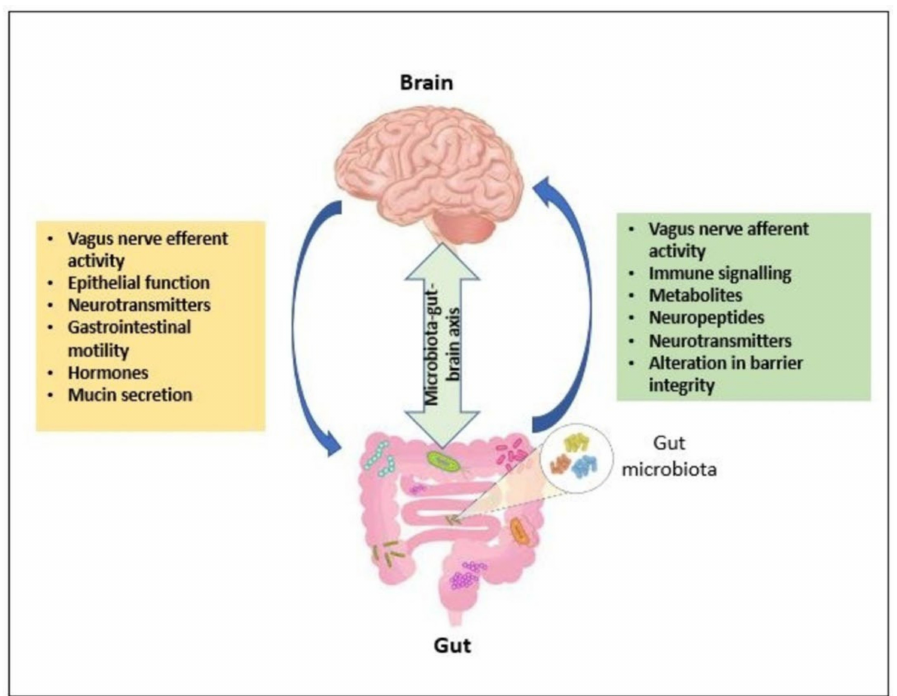
Figure 3. The microbiota–gut–brain axis. The bi-directional channel of communication between the brain, gut, and microbiota occurs in an upstream and downstream process. Upstream signaling mechanisms such as vagal afferent signaling and immune signaling are initiated from the gut through synthesis of metabolites, neuropeptides, and neurotransmitters by the gut microbiota. This influences the central nervous system (CNS) activity in response to factors within the gut environment such as alteration in intestinal barrier integrity. Downstream neurotransmitter and hormone activity within the CNS can initiate vagal efferent signaling and other metabolic pathways to influence gut environment properties such as gastrointestinal motility, mucin secretion, and epithelial